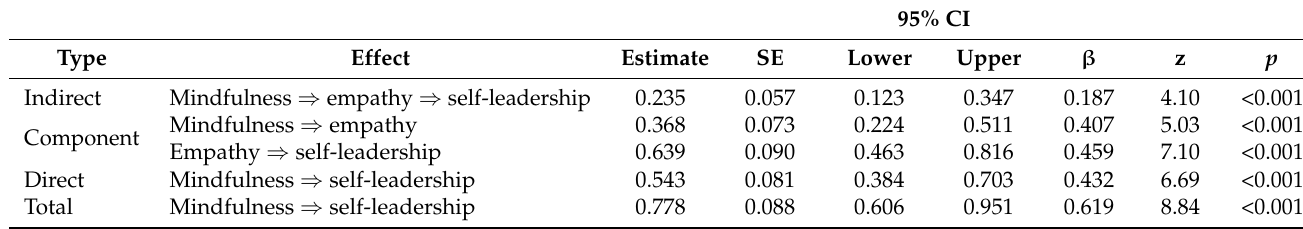
Table 3. Mediating effect of empathy between mindfulness and